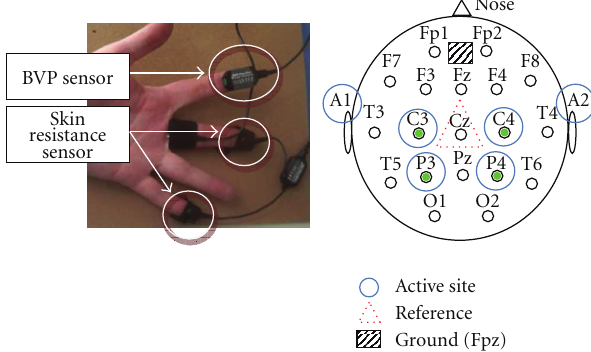
Figure 5: Montage of physiological recording setup.